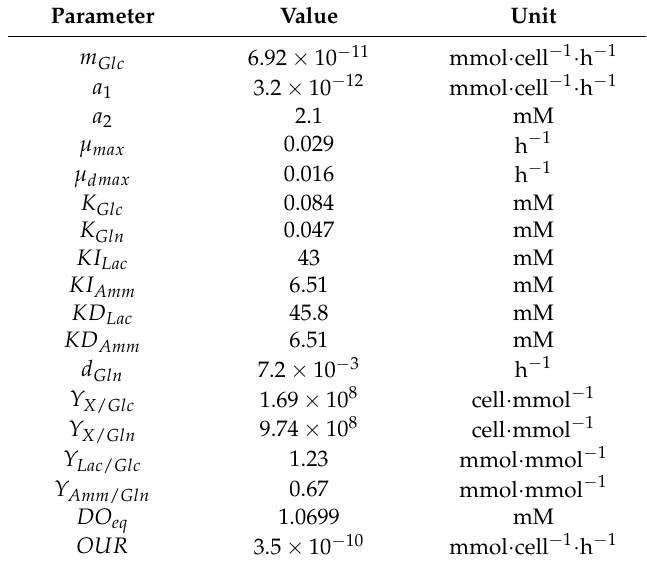
Table 2. Unstructured model